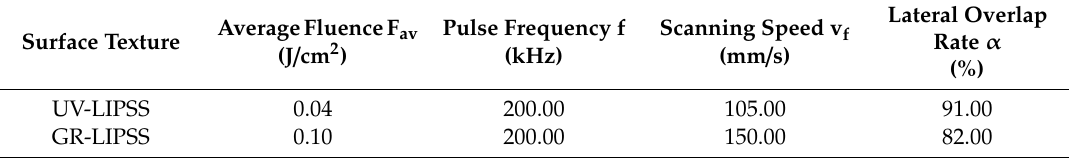
Table 2. Laser processing parameters for manufacturing the laser-induced periodic surface structures (LIPSS). Surface